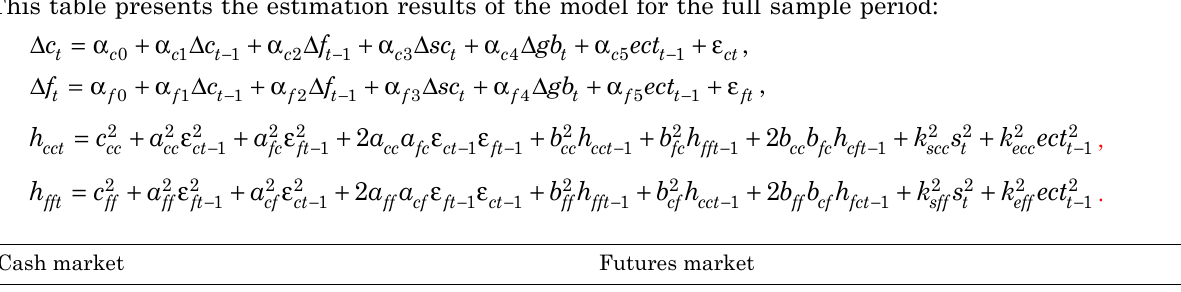
table 2. estimation of the ec-Var-BeKK-garcH-X model this table presents the estimation results of the model for the full sample